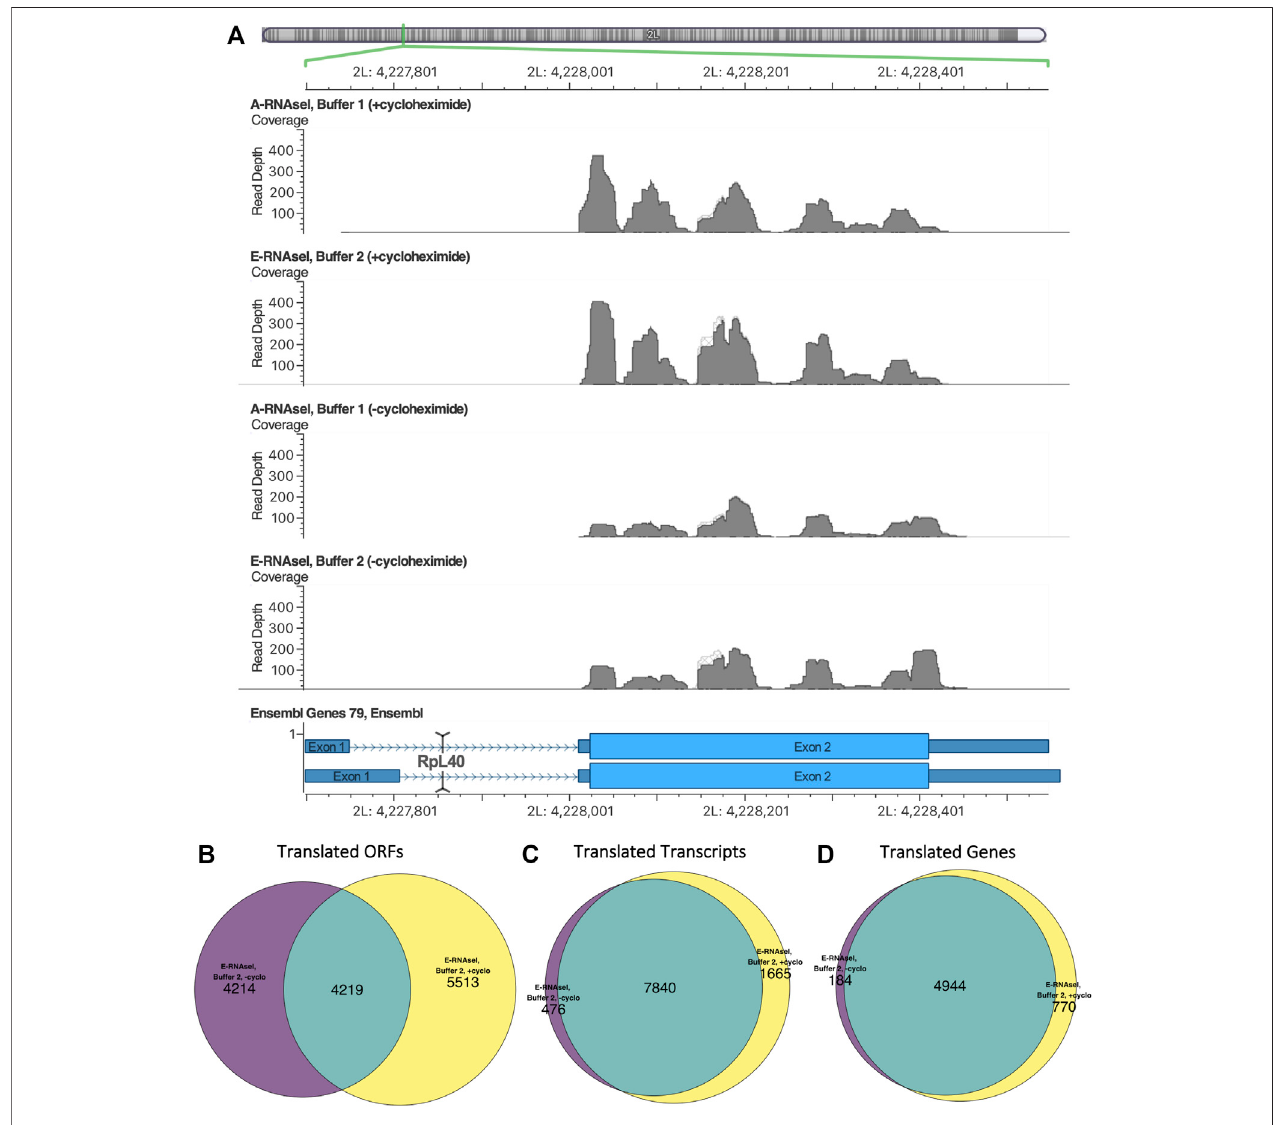
FIGURE 3 | Differences in footprinting in the presence and absence of cycloheximide in Drosophila S2 cells. (A) Ribo-seq reads mapping to RpL40 in D. melanogaster S2 cells viewed using Golden Helix GenomeBrowse (v3.0.0). The presence/absence of cycloheximide causes changes in footprint build up. Replicates with cycloheximide exhibit build up at the start of the ORF, and replicates without cycloheximide have a build up at the end of the ORF, re fl ecting a ribosomal rearrangement at the stop codon. The overlap in translation events identi fi ed in the presence and absence of cycloheximide at the (B) ORF, (C) transcript and (D) gene level in D. melanogaster S2 cells, footprinted with E-RNaseI in Buffer